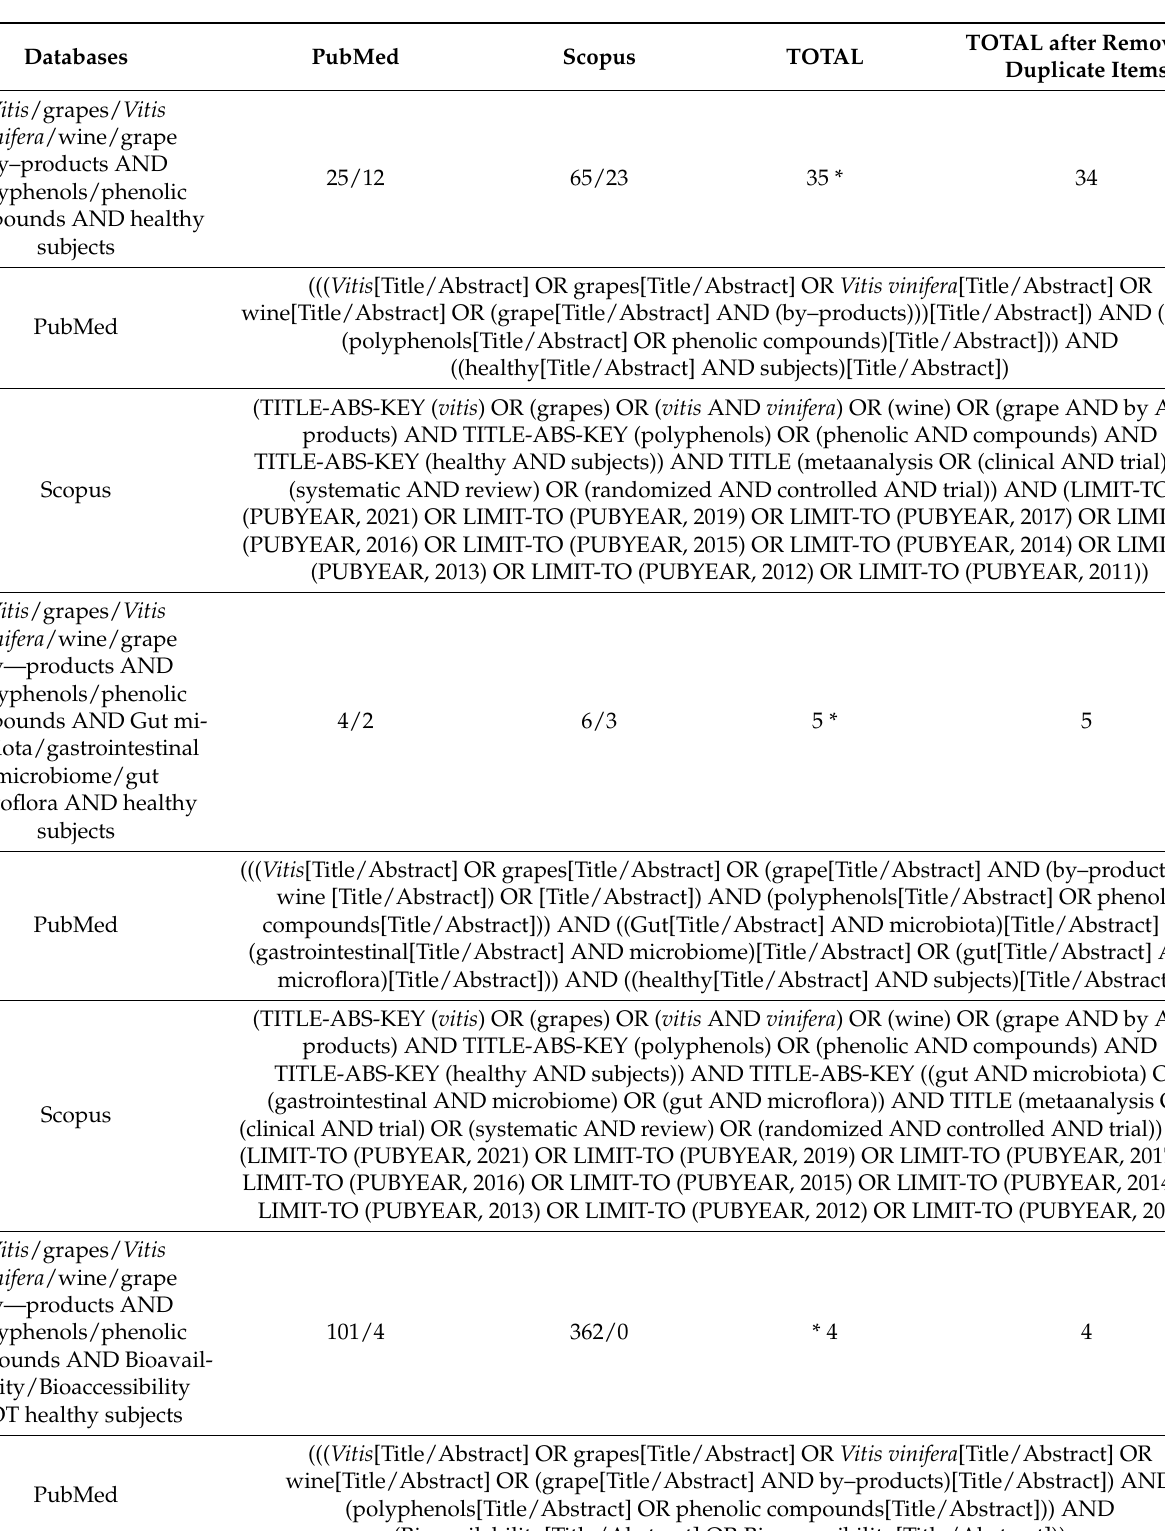
Table 3. Database searching (April 2021) format on grape, grape by-products polyphenols, gut microbiota, and